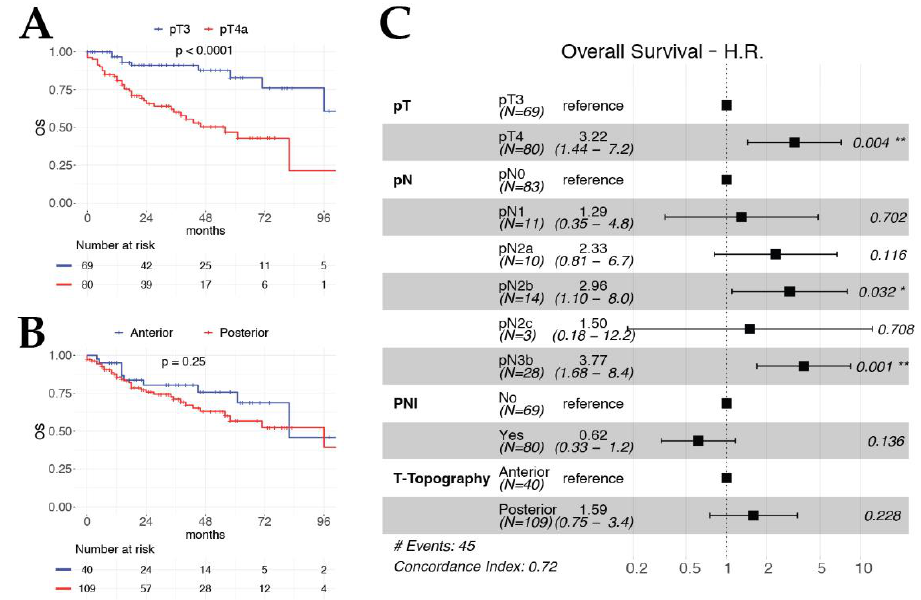
Figure 1. Kaplan–Meier curves for OS according to pT category ( A ) and T-topography ( B ). ( C ) Forest plot of OS multivariable model.